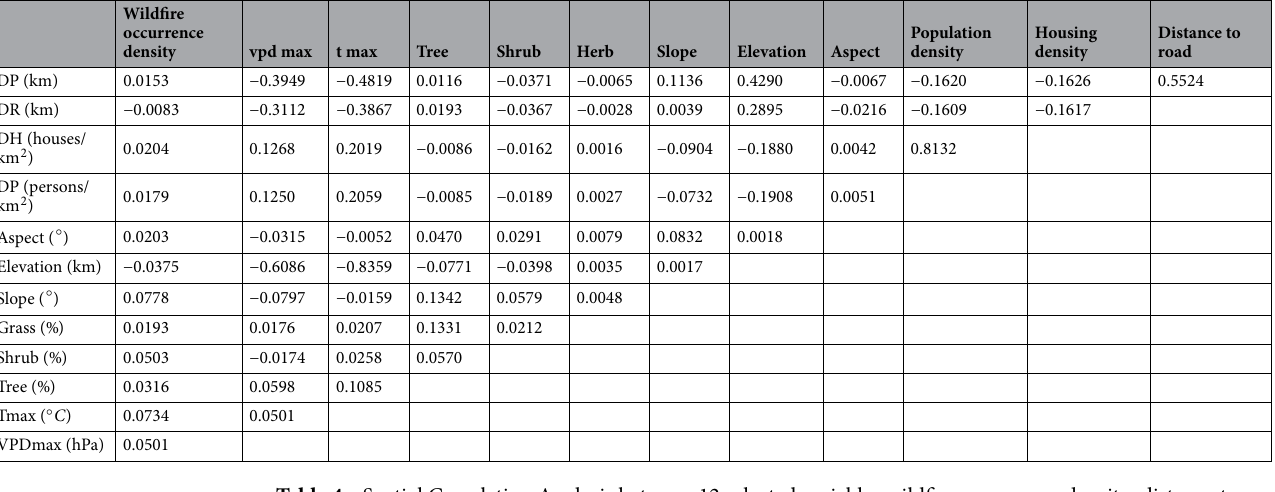
Table 4. Spatial Correlation Analysis between 12 selected variables wildfire occurrence density: distance to power line (DP), distance to road (DR), housing density (DH), population density (DP), elevation,